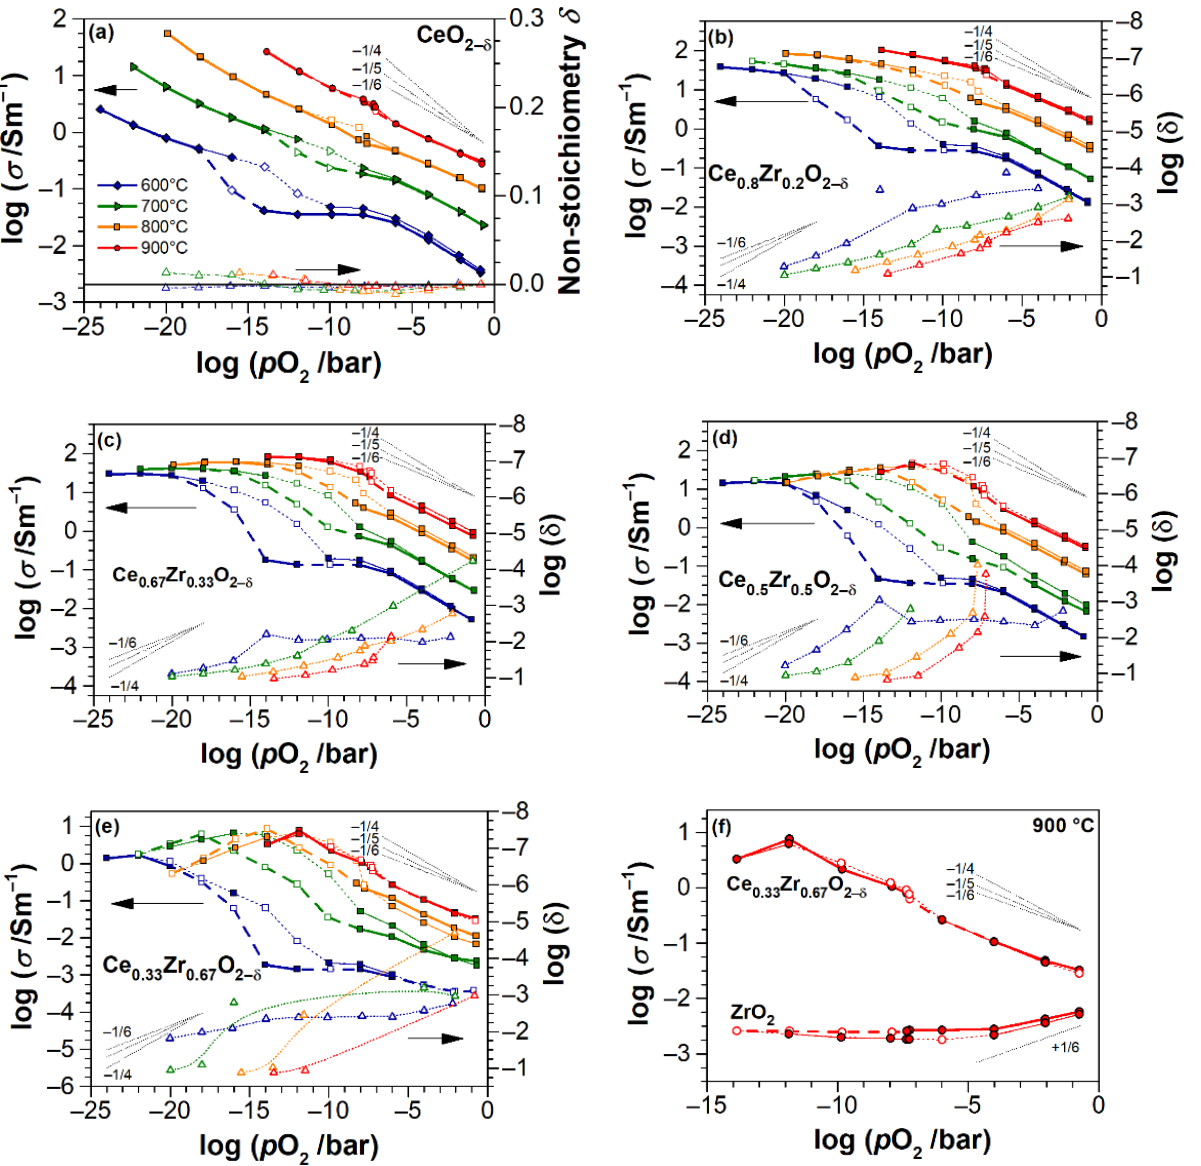
Figure 8. The p O 2 -dependences of conductivity σ and oxygen non-stoichiometry δ of CZO thin films at different isotherms (see legend in ( a )). For CeO 2 −δ the oxygen deficiency δ is plotted line- arly.